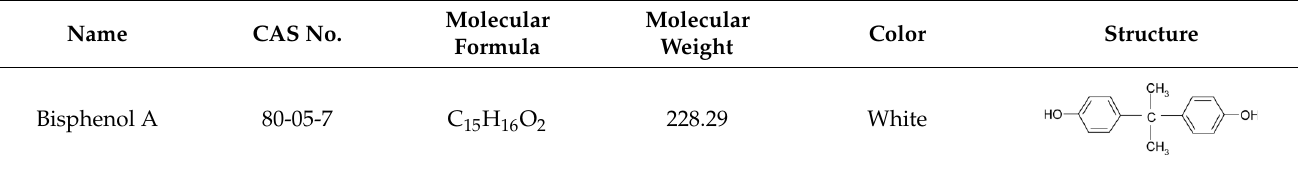
Table 1. Properties of BPA.